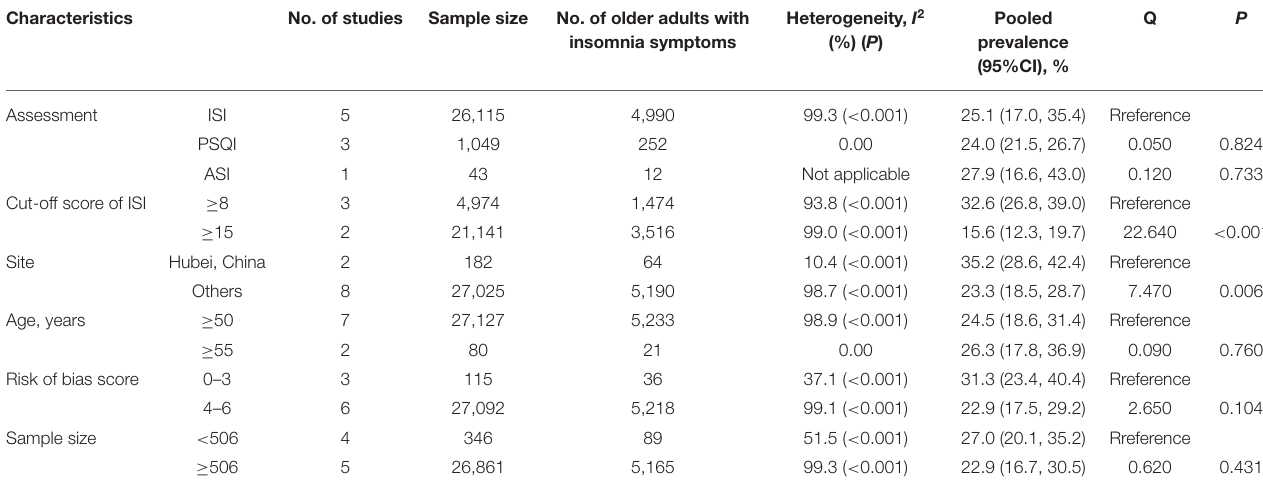
TABLE 2 | Subgroup analysis of the source of heterogeneity of included